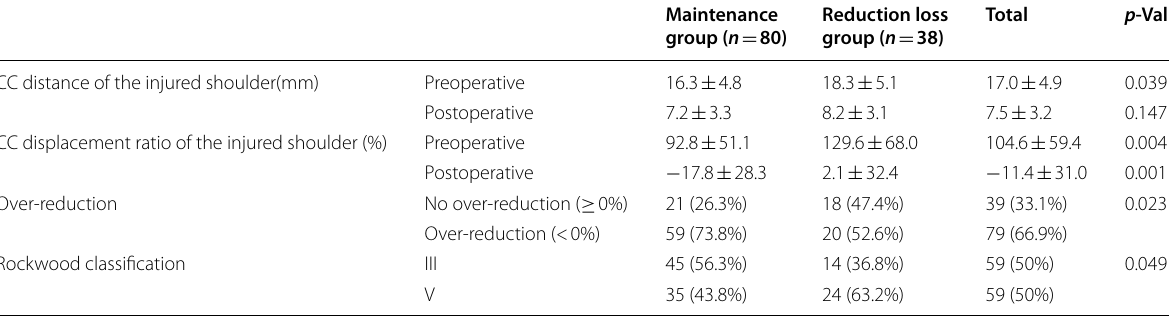
Table 3 Comparison of radiographic factors between the maintenance and reduction loss groups